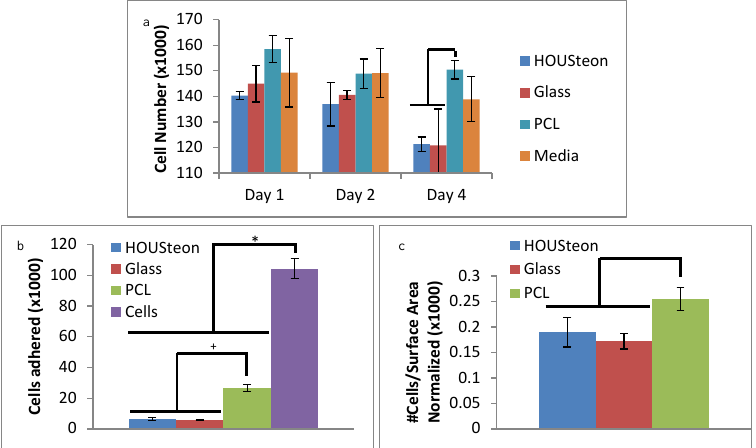
Figure 7. Cell assays of ( a ) in vitro cytotoxicity and ( b,c ) adherence. ( c ) Cells adhered to the scaffolds were normalized to the available surface area on the scaffolds and to the cell control. * and + denote statistical significance ( p <